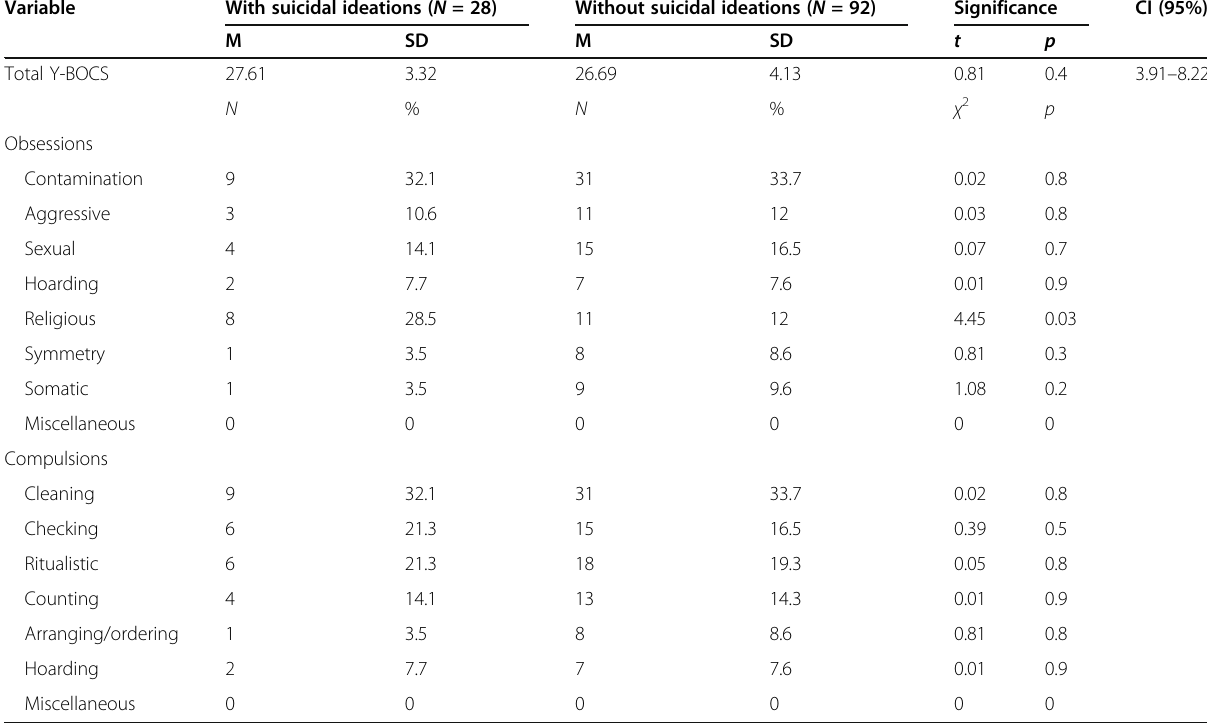
Table 2 OCD clinical characteristics comparison between OCD patients with and without current suicidal ideations ( n = 120) Variable